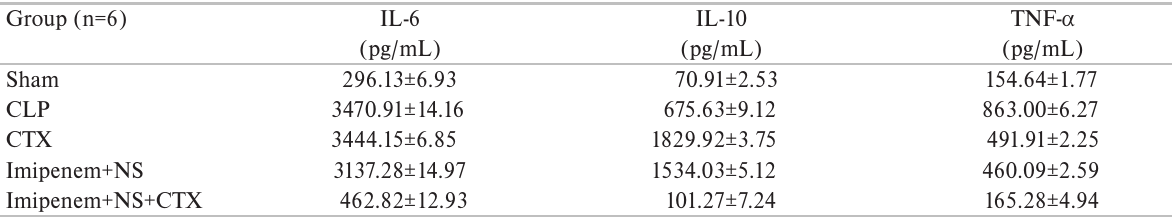
Table 1. Level of serum IL-6, IL-10 and TNF-α.